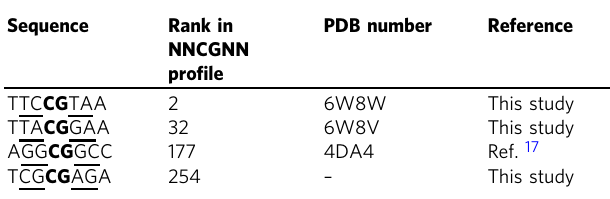
Table 2 Oligonucleotide sequences used for DNMT1 structural